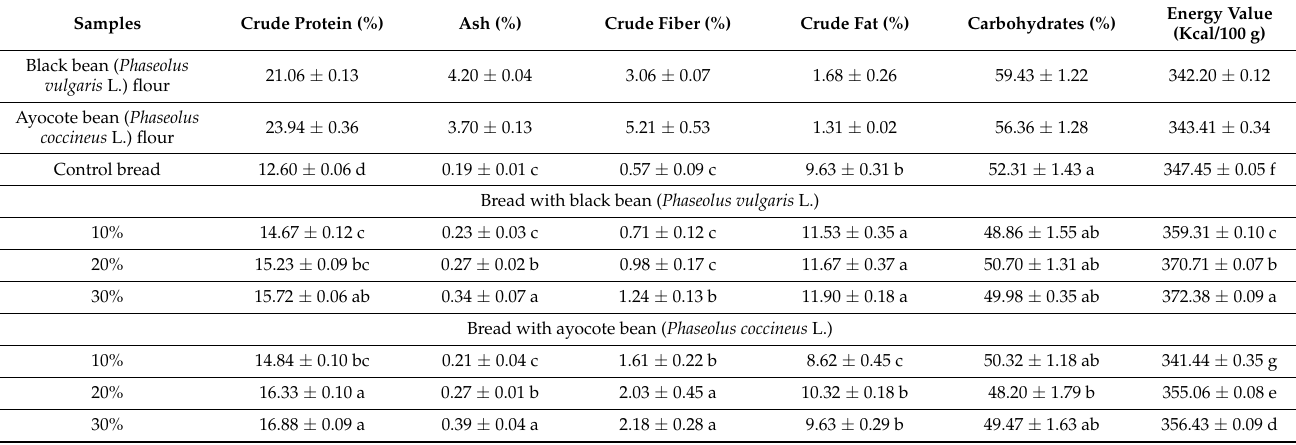
Table 2. Proximate composition of black bean (BB), ayocote bean (AB), control bread and breads with 10, 20 and 30% of wheat flour substitution with BB and AB in dry weight basis *.